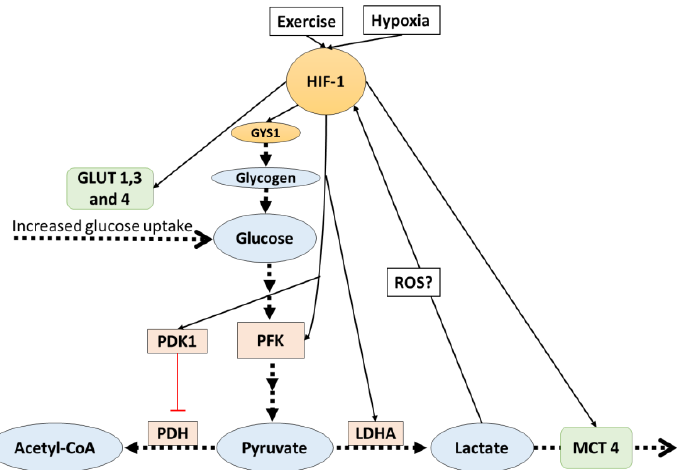
Figure 1. HIF-1 activates signals which favor lactate production. Additionally, lactate indirectly affects HIF-1. The dotted arrows indicate transport and reactions, solid lines indicate increased (black) or inhibit (red) gene expression. HIF-1: hypoxia inducible factor-1; PDK: pyruvate dehydrogenase kinase 1; PFK: phosphofructokinase; PDH: pyruvate dehydrogenase; LDHA: lactate dehydrogenase A; ROS: reactive oxygen species; MCT4: monocarboxylate transporter 4.